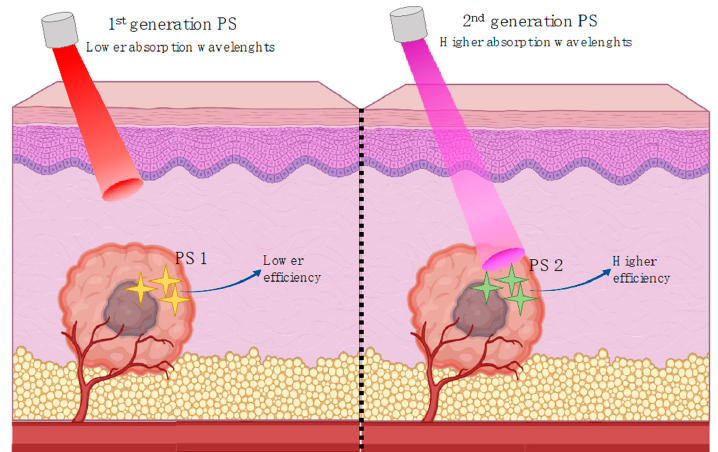
Figure 5. Penetration capacity of different absorption wavelength lights for 1st generation PS and 2nd generation PS. At higher wavelengths, the light can have a deeper penetration through tissues therefore enhancing the activation of the photosensitizer.